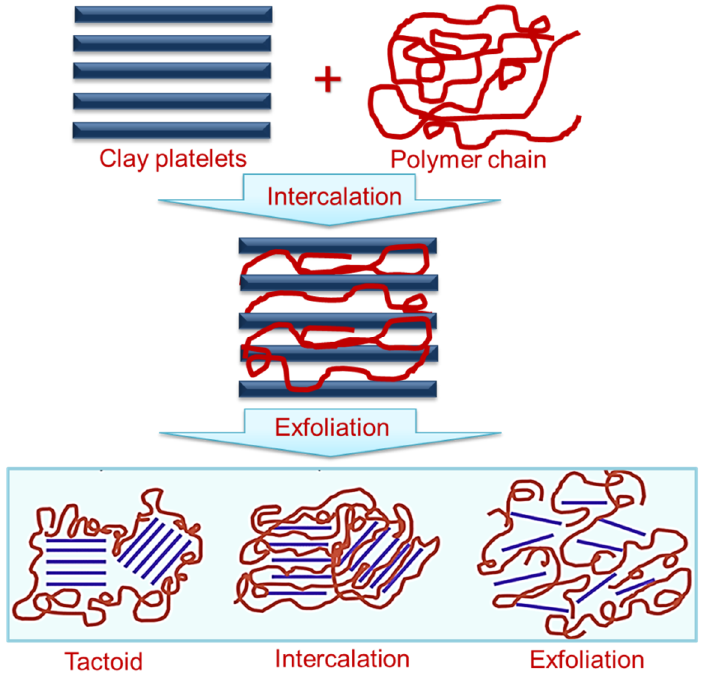
Figure 3. Formation of polymer/layered silicate nanostructure via intercalation and exfoliation.